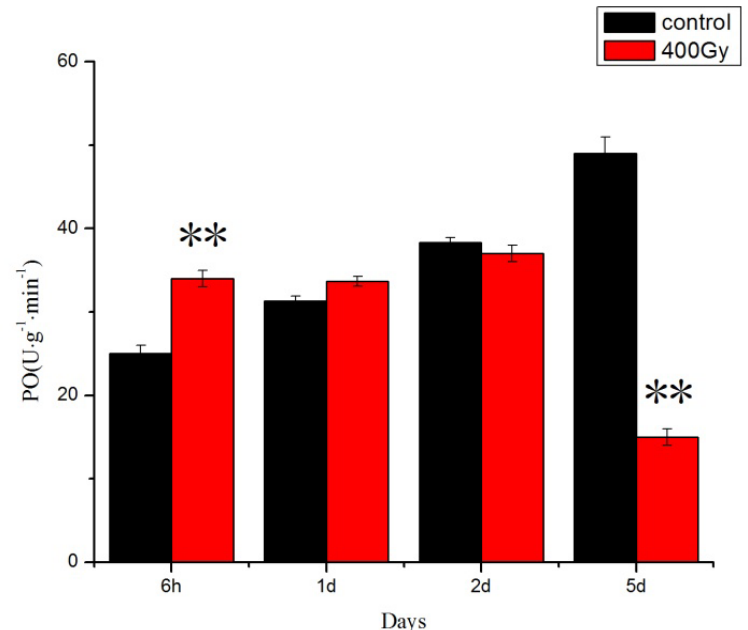
Figure 4. Effects of 60 Co- γ irradiation on PO activity of P. citri adults for different lengths of time. Values are mean ± SD ( n = 3). Asterisk designates statistically significant difference between control and irradiated adults (** p <